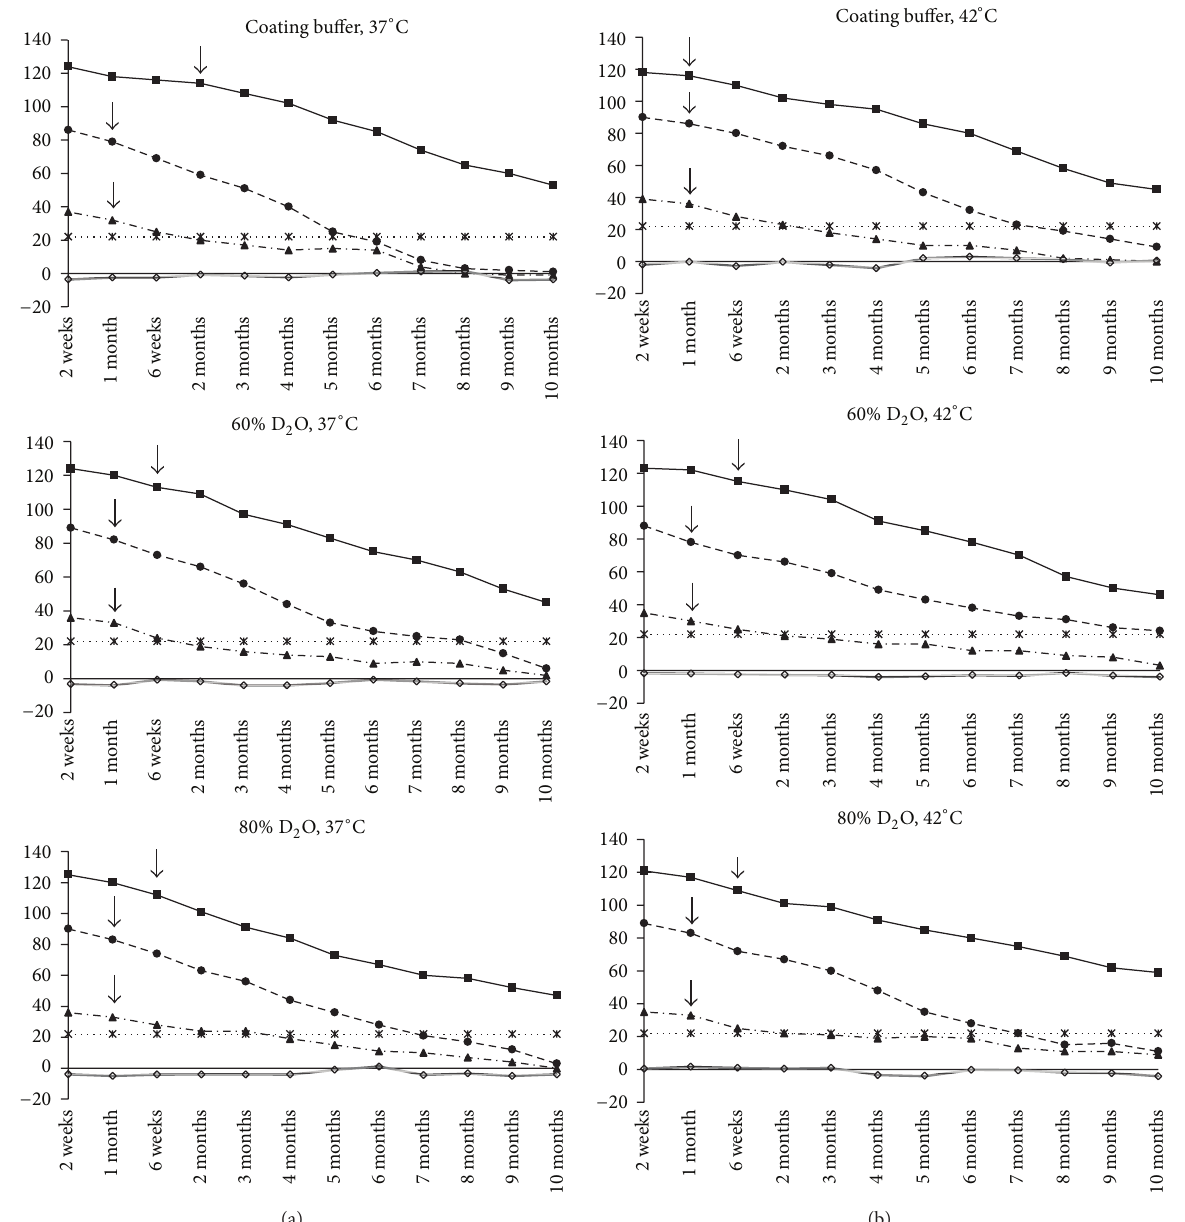
Figure 2: Thermostability of rp26 ELISA at 37 ∘ C (a) and at 42 ∘ C (b). Duration of thermostability is indicated by arrow ( ↓ ) against each strong serum positive serum ( ◼ ), medium positive serum ( e ), and weak positive serum ( 󳵳 ). No significant difference exists in 60% D 2 O versus 80% D 2